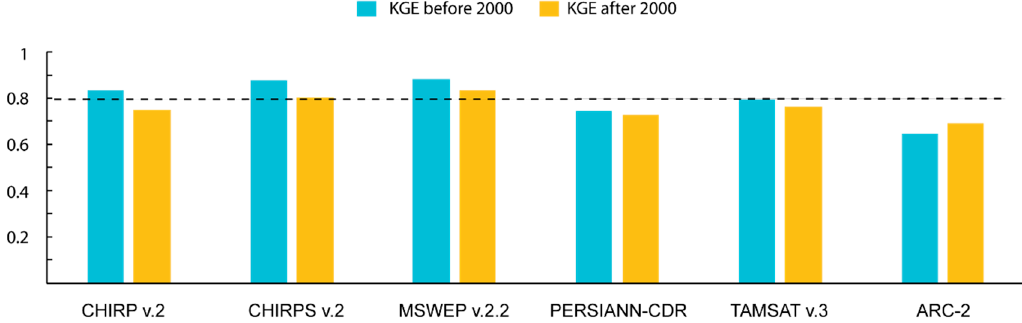
Figure 8. Median KGE values obtained from all the grid cell levels before and after 2000.